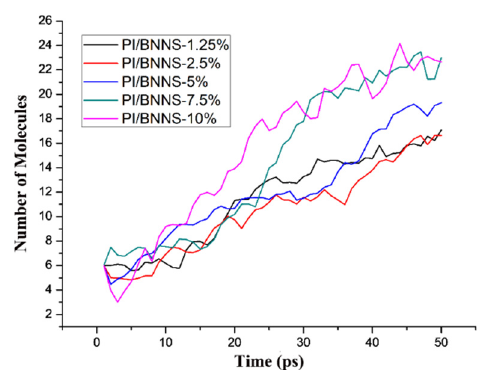
Figure 11. Variation in the molecular number over time for PI/BNNS systems with different doping ratios at a 200 kV/mm field intensity.